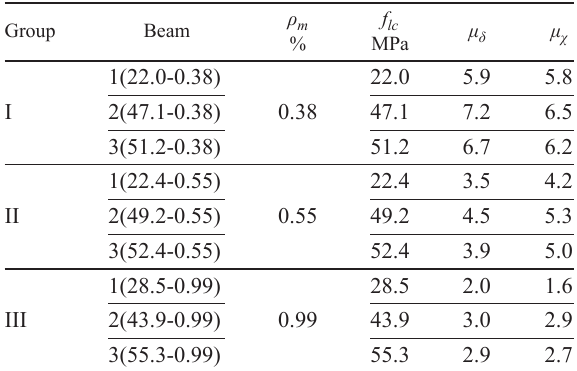
Table 6. Beams groups with similar reinforcement ratio Group